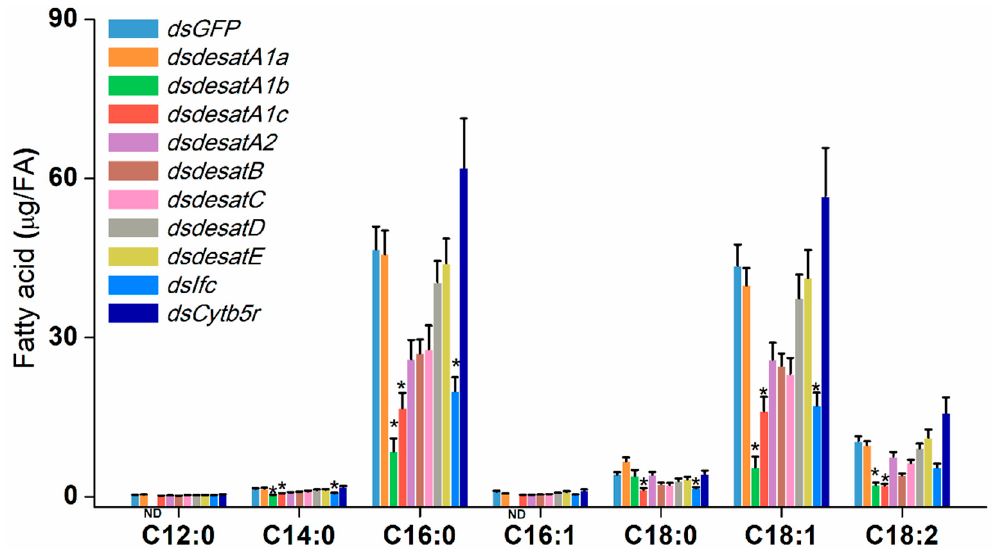
Figure 7. The effect of single knockdown of Nlug-desat s on fatty acids in BPH. Mean contents (+SE, n = 3) of fatty acids in the whole body of a 1-d-old-female BPH adult (FA) at 3 days after injection of the dsRNA of 10 N. lugens desaturase genes or GFP ( dsGFP ). (A) C12:0, lauric acid; C14:0, myristic acid; C16:0, palmitic acid; C16:1, palmitoleic acid; C18:0, stearic acid; C18:1, oleic acid; C18:2, linoleic acid. ND, no detection. Differences in specific fatty acid levels between the control group (dsGFP-BPH) and each treatment group were determined by Brown-Forsythe and Welch ANOVA followed by Dunnett’s T3 multiple comparisons test. Asterisks indicate significant difference between dsGFP injection and each dsdesat injection treatments ( p < 0.05). Statistical information is provided in Table S6.